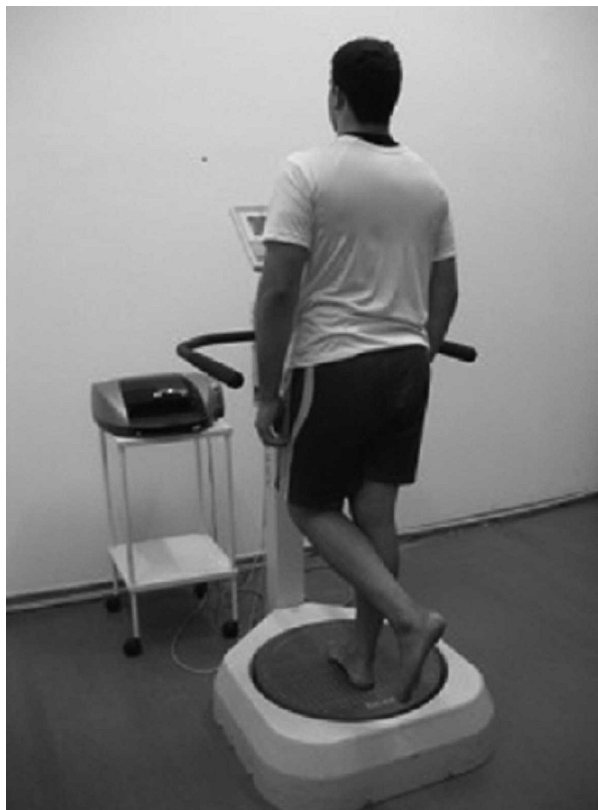
Figure 2 - An athlete performing the platform stability test.